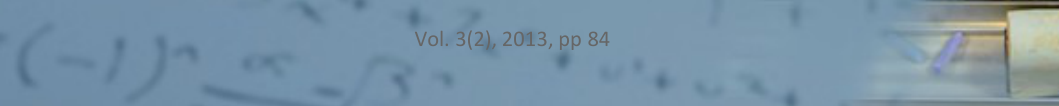
Figure 3. Gross C and N mineralizaton and net producton of ammonia and nitrate at the end of the simulaton, in relaton to organic C content of the